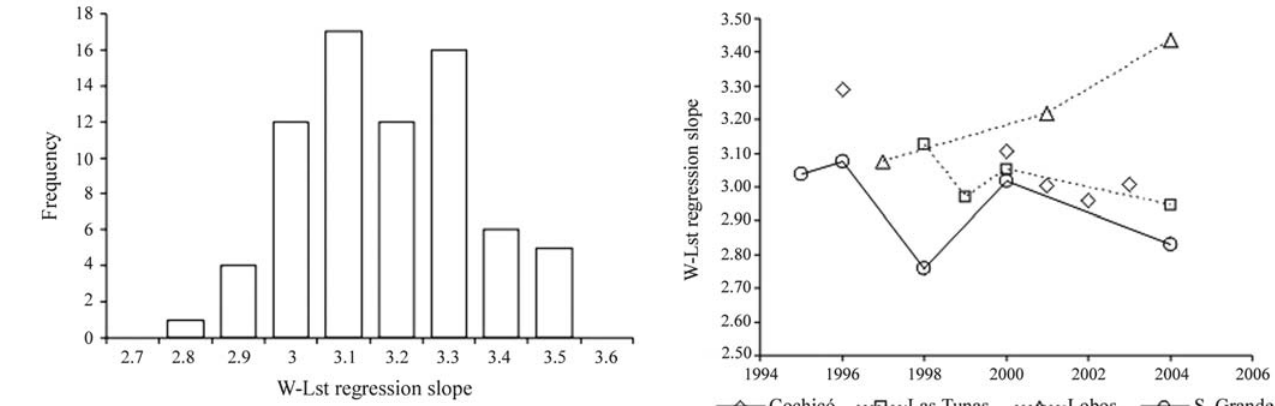
Fig. 4. Distribution of weight-length regression slopes of 74 sampled populations (adapted from Colautti et al .,